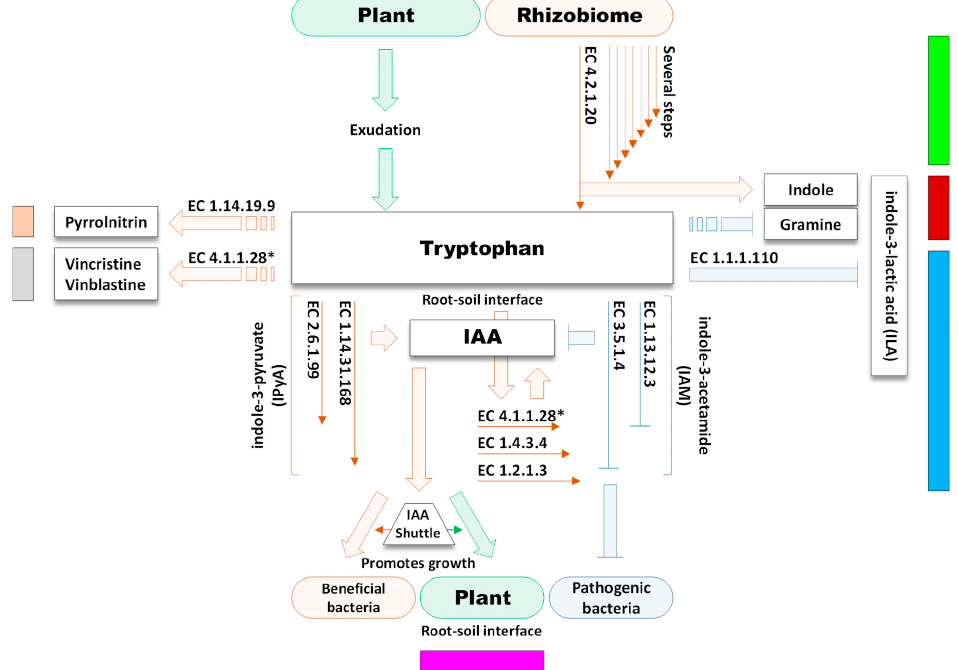
Figure 6. Enrollment of tryptophan in plant ‐ microbe interaction at root ‐ soil interface and its participation in a number of cross ‐ talking pathways in the rhizobiome of M. oleifera . Light blue box = pathway “Tryptophan metabolism”; dark red box = pathway “Biosynthesis of various plant sec ‐ ondary metabolites”; light green box = pathway “Phenylalanine, tyrosine and tryptophan biosynthesis”; light brown box = pathway “Staurosporine biosynthesis”; gray box = pathway “Indole alkaloid biosynthesis”; and pink box = pathway “Plant hormone signal transduction”. (Clockwise) EC 4.2.1.20 = tryptophan synthase; EC 1.1.1.110 = aromatic 2-oxoacid reductase; EC1.13.12.3 = tryptophan 2-monooxygenase; EC 3.5.1.4 = amidase; EC 4.1.1.28 = aromatic-L- amino-acid decarboxylase; EC 1.4.3.4 =